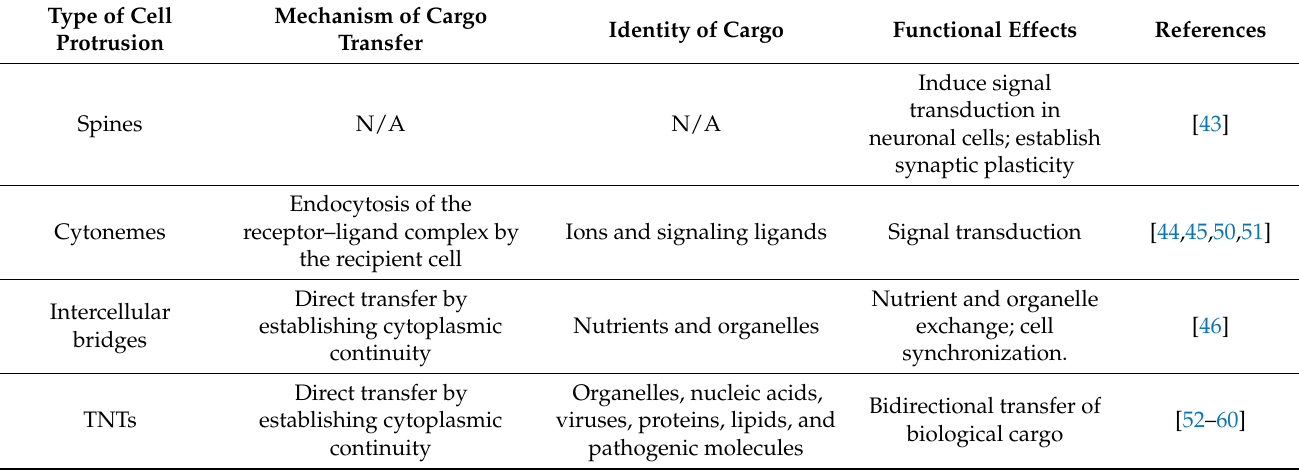
Table 1. Overview of canonical communicative cell